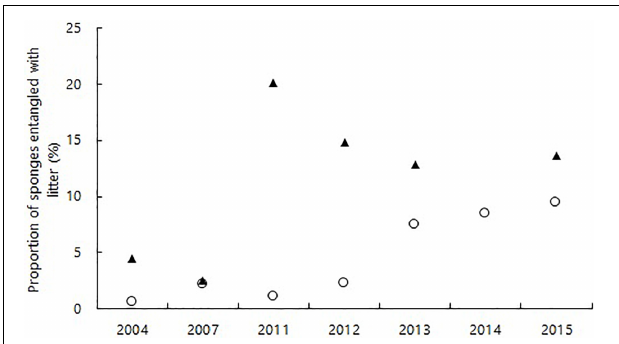
FIGURE 5 | Proportion of the sponges Cladorhiza gelida and Caulophacus arcticus entangled with marine litter at N3 (white circles) and S3 (black triangles) between 2004 and